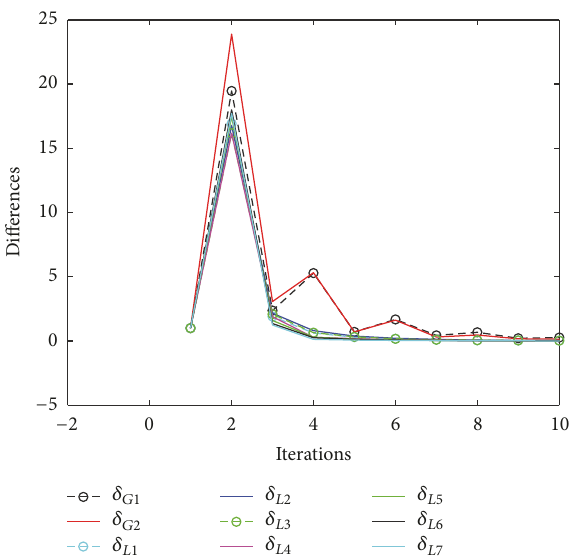
Figure 3: The trajectories of infinity norm of hourly differences.